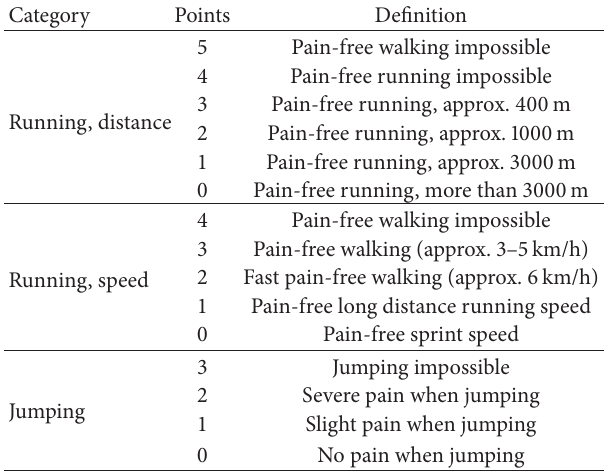
Table 1: Scores for determining the exercise tolerance of